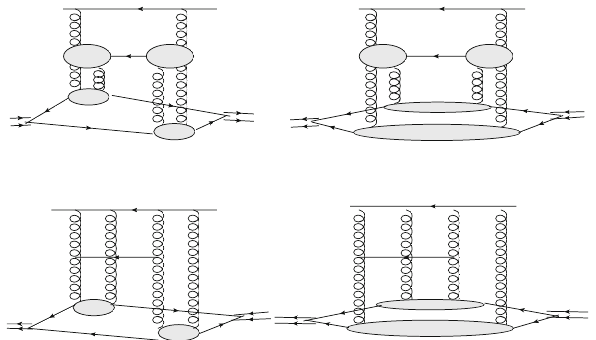
Fig. 7 Typical amplitudes with the coupling to the nuclear target explicitly shown